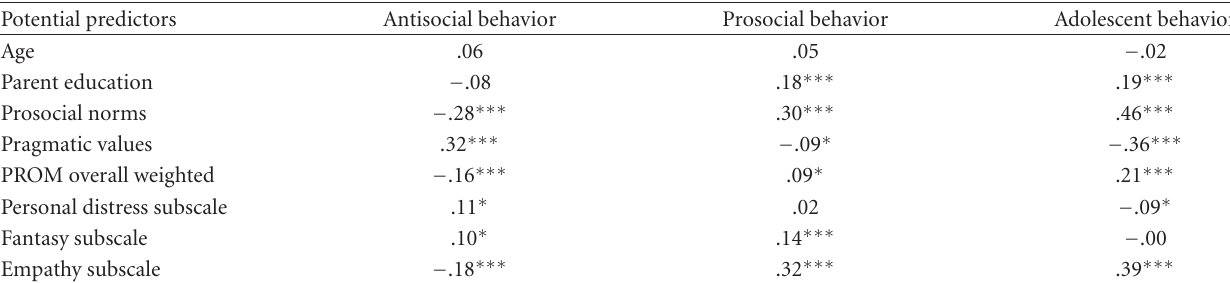
Table 2: Correlations between potential predictors and adolescent antisocial and prosocial